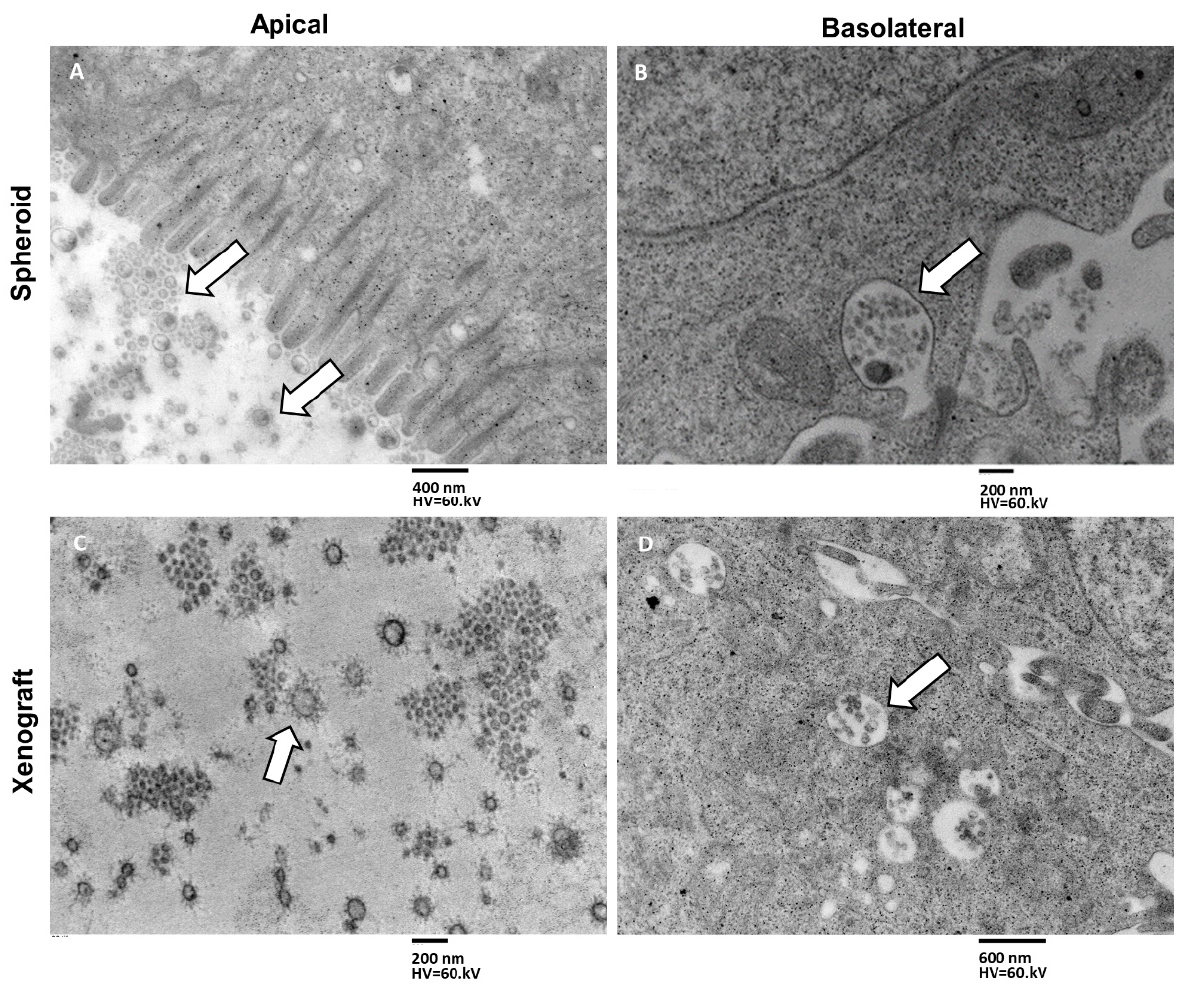
Figure 10. ( A ) Type C spheroid, apical surface secretion, exosomes (arrows) appear surrounded by